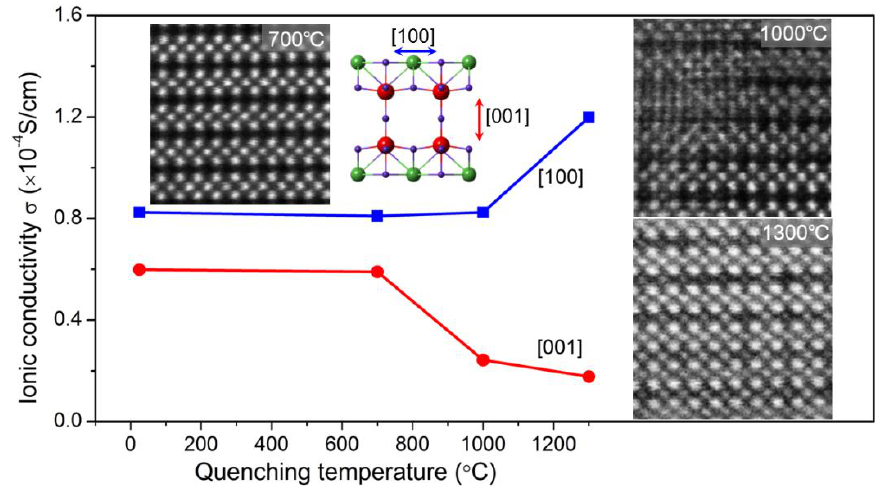
Figure 8. Quenching-induced defects and anisotropic changes in ionic